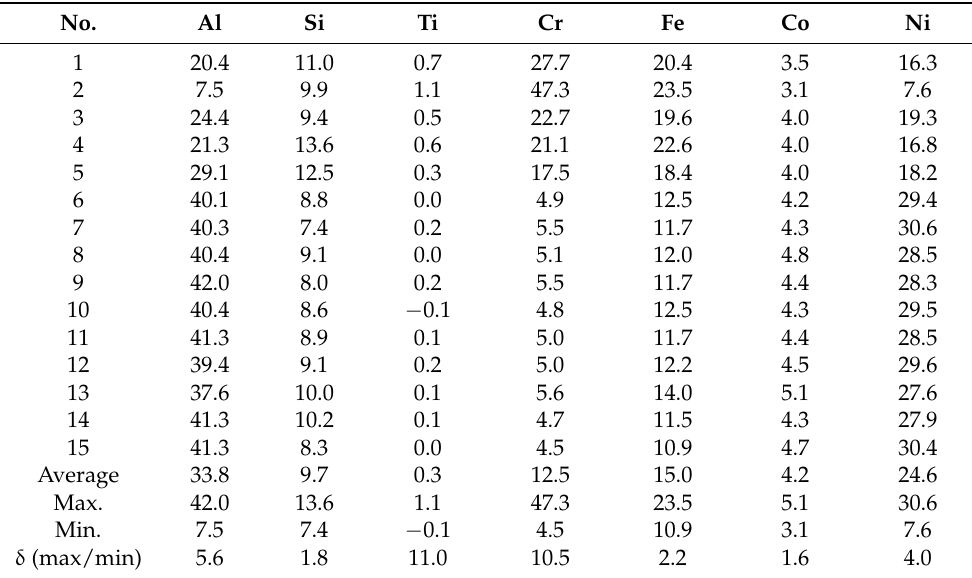
Average is the mean value of the content of the element. Max is the maximum value of the content of the element. Min is the minimum value of the content of the element. δ (max/min) is the maximum value divided by the minimum value of the content of the element.